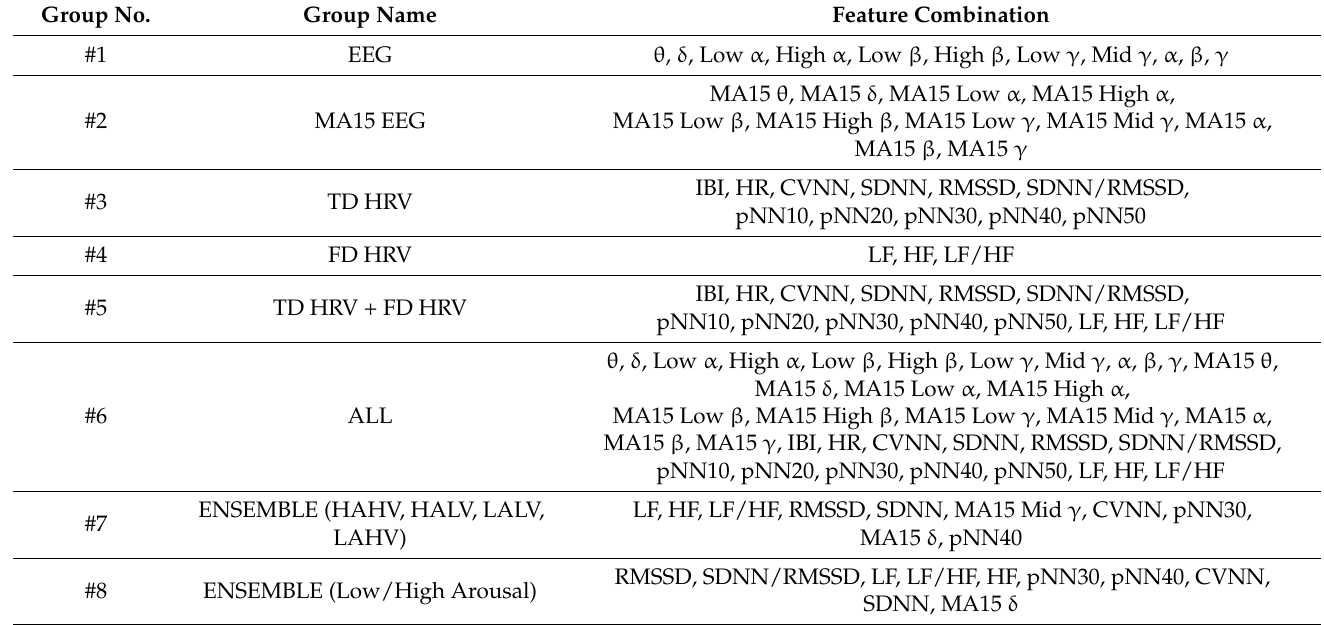
Table 3. Groups of feature combinations from EEG and/or HRV